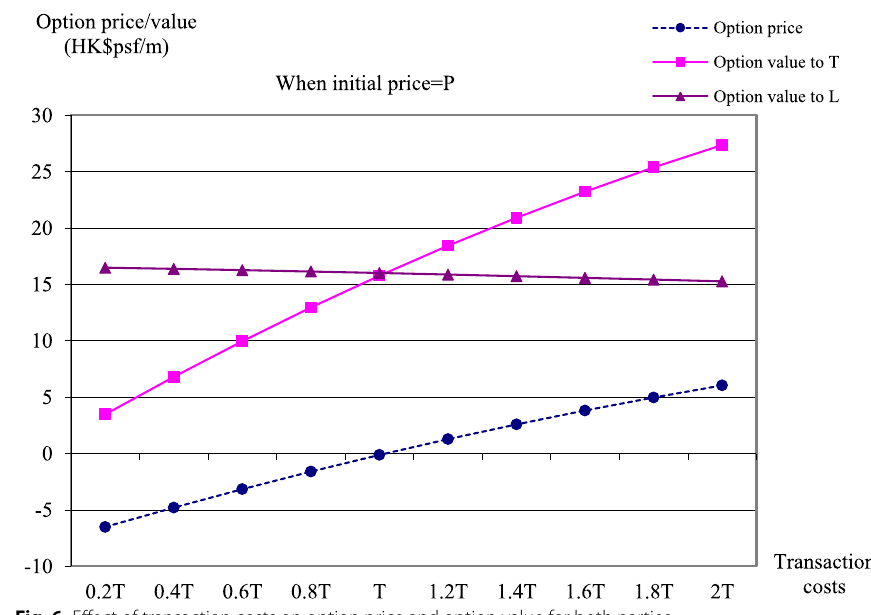
Fig. 6 Effect of transaction costs on option price and option value for both